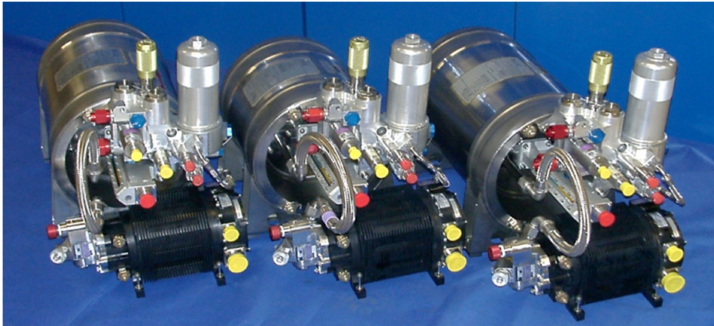
Figure 9. Local electro-hydraulic generation systems on the Airbus A380.